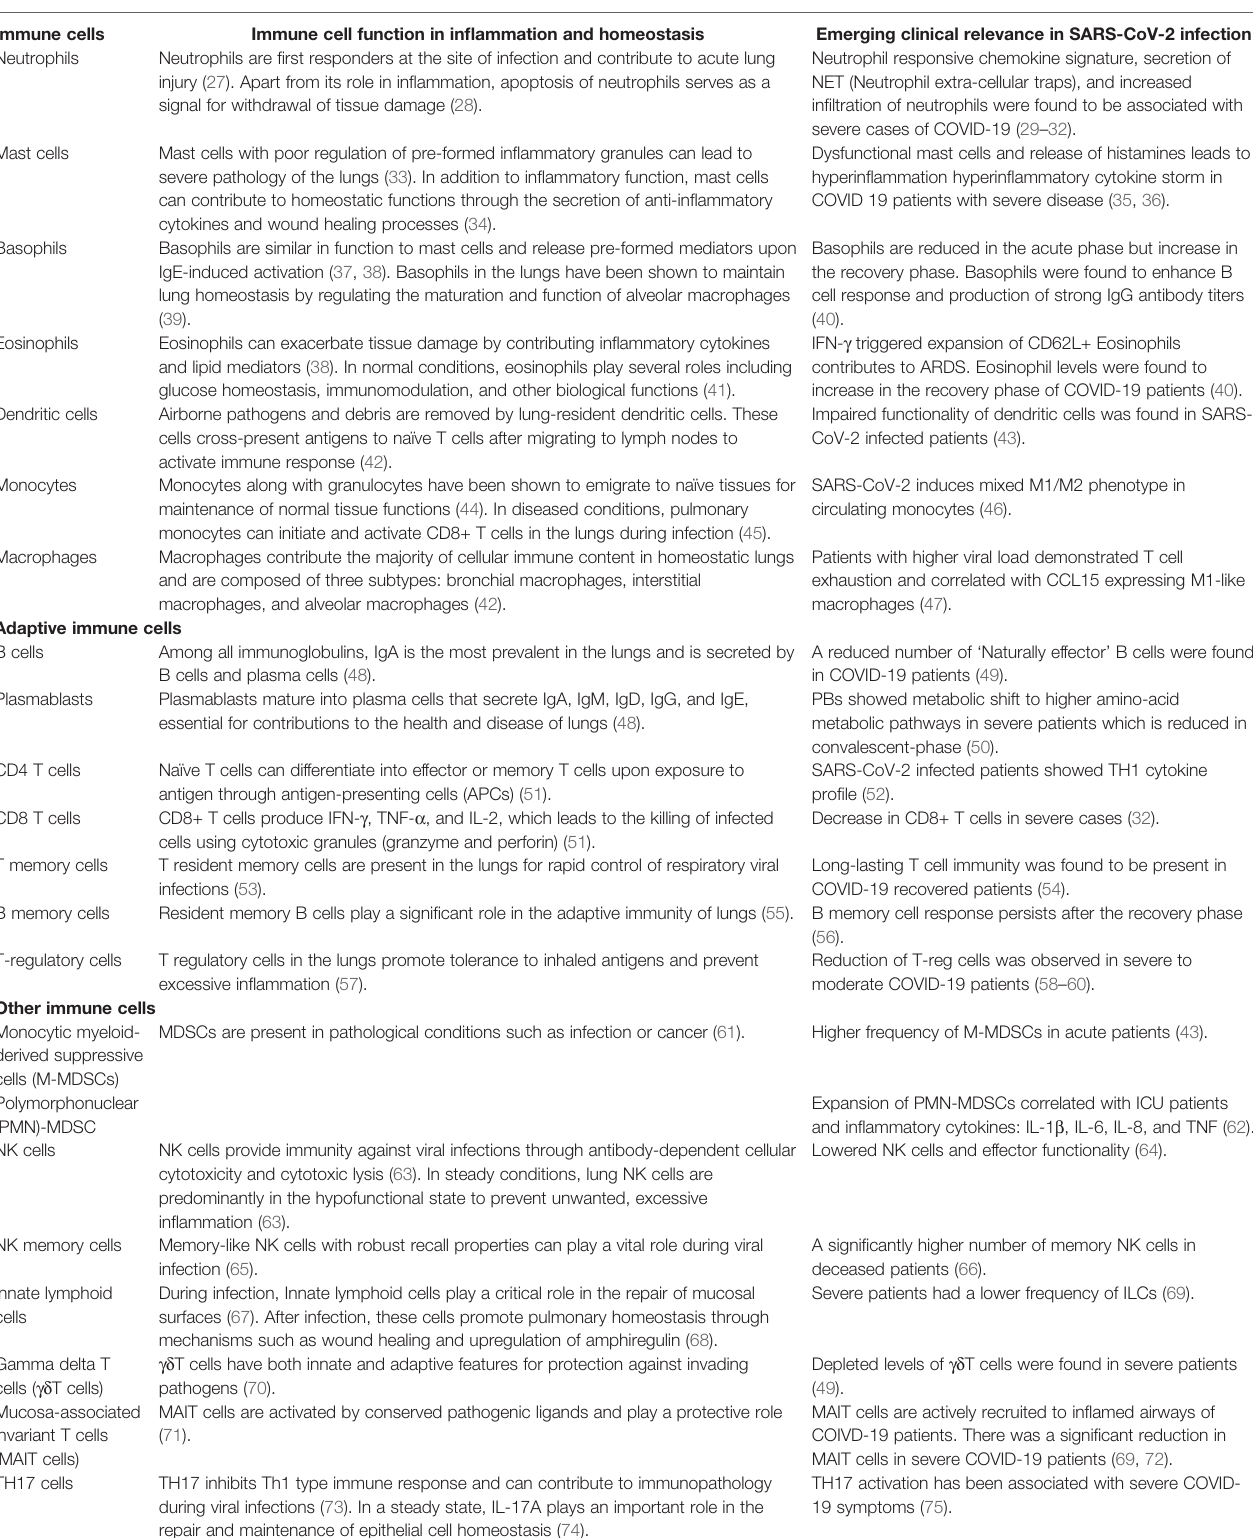
TABLE 1 | The role of immune cells in in fl ammation, homeostasis, and SARS-CoV-2 pathophysiology. Innate immune cells Immune